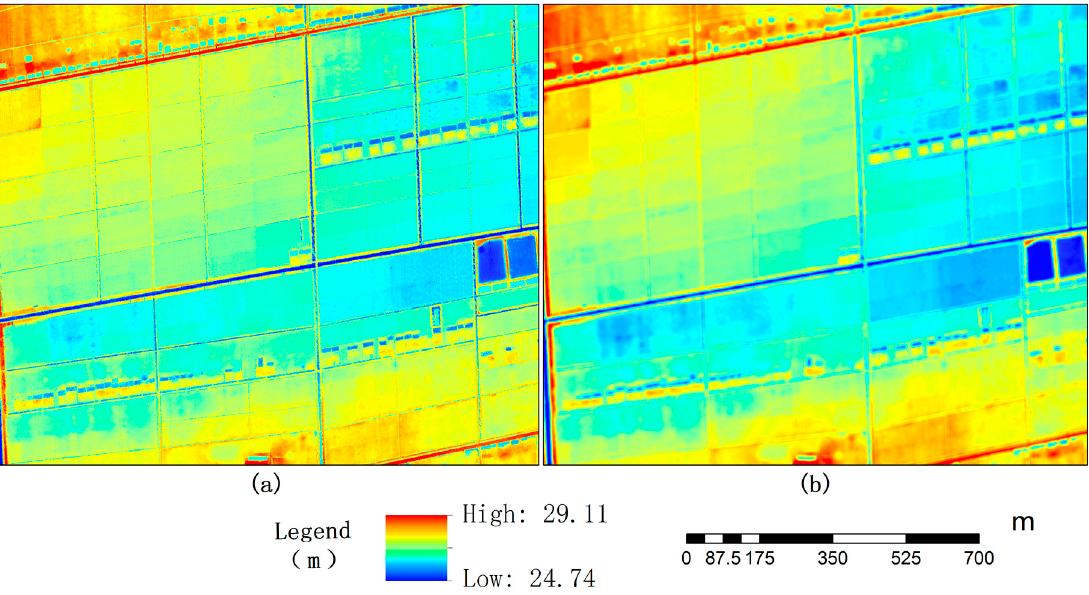
Figure 4. Smoothed surface: ( a ) original surface, and ( b ) smoothed surface.